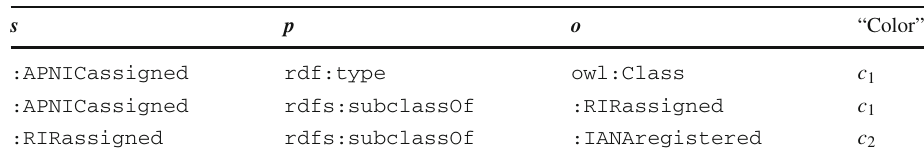
Table 2 RDF triple